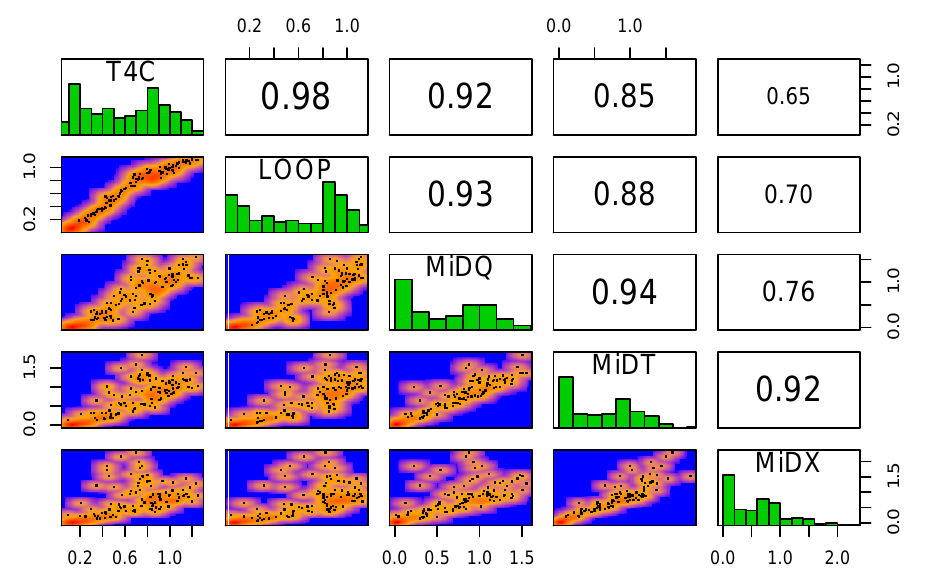
Figure 9. Pairwise comparison of five possible exposure values. The density plots display the measure on the right of each row on the y -axis versus the measure on the top of each column on the x -axis, giving more detailed information than just the correlation